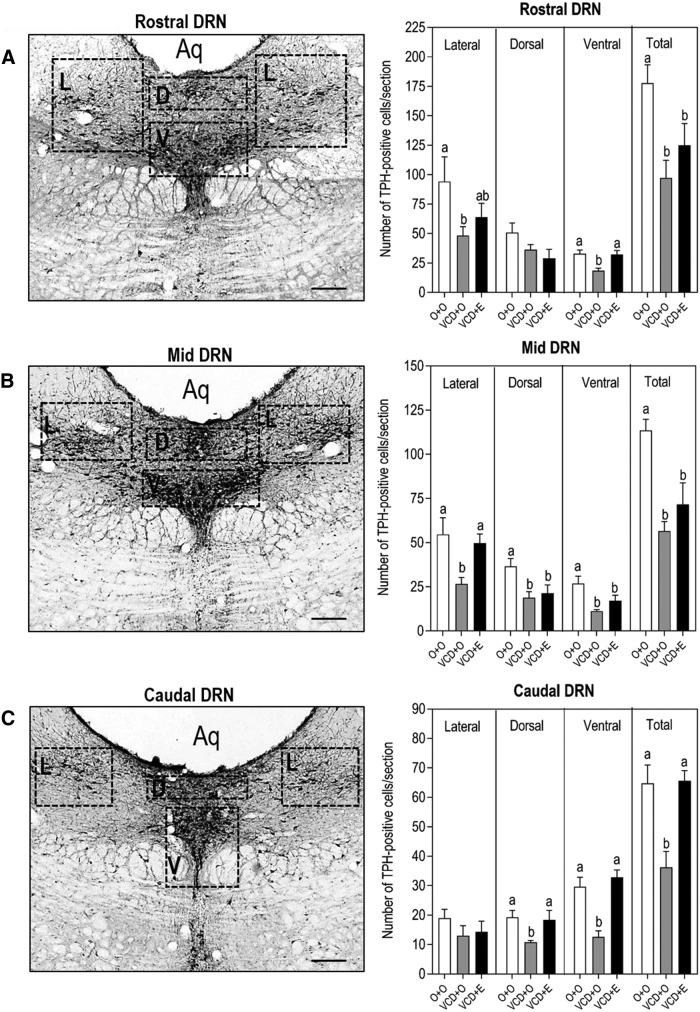
Effect of follicular depletion induced by VCD and chronic 17β-estradiol (E) administration on TPH immunoreactivity in the DRN. Representative photomicrographies (10×) of coronal sections of the DRN immunostained for TPH in rostral (A; -7.32 mm from bregma), mid (B; -7.80 mm from bregma), and caudal (C; -8.28 mm from bregma) sections of the DRN. Dotted boxes indicate the lateral (L), dorsal (D), and ventral (V) subregions at each level of the DRN. Aq, aqueduct. Scale bar: 50 µm. Bargraphs show the number of TPH-positive cells per section in the rostral (top panel), mid (mid panel), and caudal (lower panel) sections of the DRN. Female rats at 28 d of age were subcutaneously injected with corn oil (O) or VCD for 15 consecutive days. Fifty-five days after the first injection of VCD/oil, rats received a subcutaneous capsule that contained corn oil (groups O + O and VCD + O) or 17β-estradiol (VCD + E). Rats were perfused during the diestrous phase (O + O and VCD + O groups) or 21 d after the onset of E therapy (VCD + E), from 75 to 85 d after the onset of VCD/oil administration, between 9:00 and 11:00 A.M. These photomicrographies represent sections of a O + O rat. Data are presented as the mean ± SEM. Significance was accepted at p < 0.05. Different letters indicate significant differences (n = 4-6).